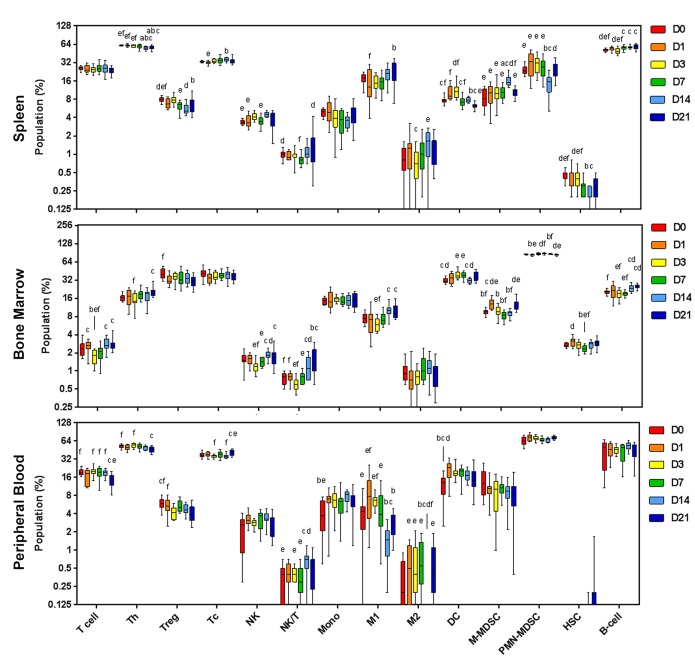
Systemic immune cell populations.Immune cell populations from spleen, bone marrow and peripheral blood from mice inoculated with glioma Gl261 cells. Cells were harvested at day 0 (sham) to day 21 time points and assessed by multi-color flow cytometry. Data are expressed as percentage of parent population (%). ap<0.05 vs D0, bp<0.05 vs D1, cp<0.05 vs D3, dp<0.05 vs D7; ep<0.05 vs D14; fp<0.05 vs D21 by Dunn’s Multiple Comparison Test.